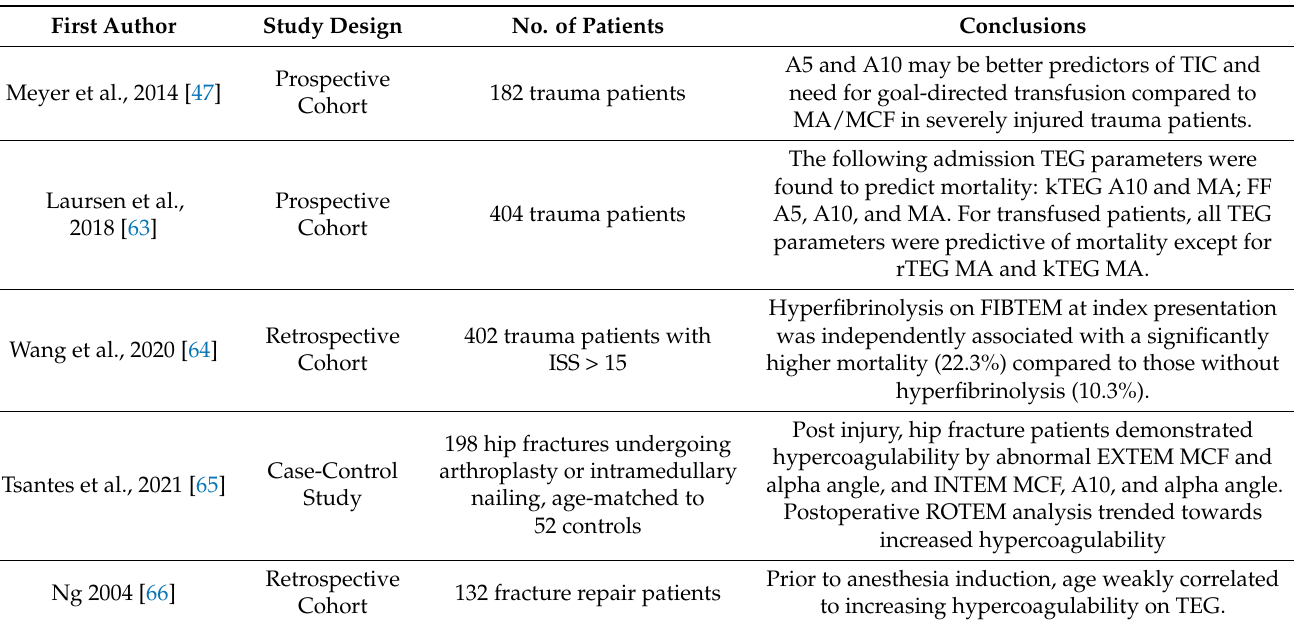
Table 4. Summary of the literature pertaining to viscoelastic hemostatic assay-guided goal-directed therapy for orthopedic